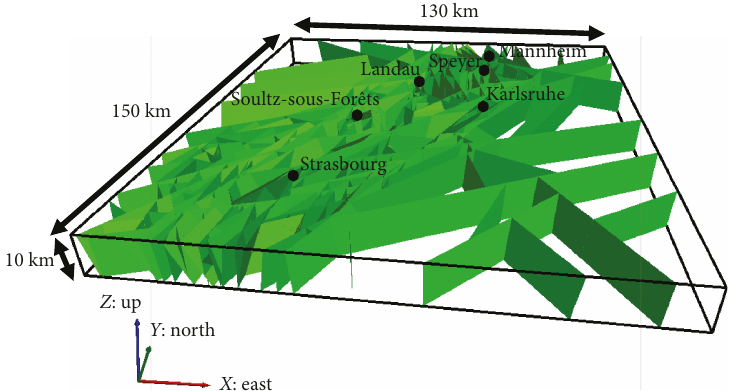
Figure 3: Final DFN considered in the